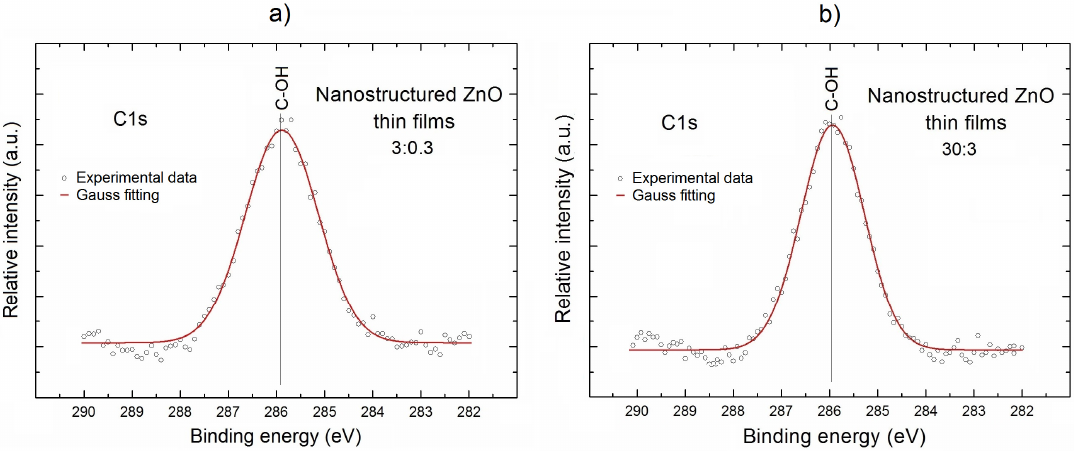
Figure 5. The XPS C1s lines after deconvolution using Gauss fitting for the selected nanostructured ZnO thin films deposited at Ar/O 2 gas flow of 3:0.3 ( a ) and 30:3 ( b ), respectively, having the most different C total relative concentration.